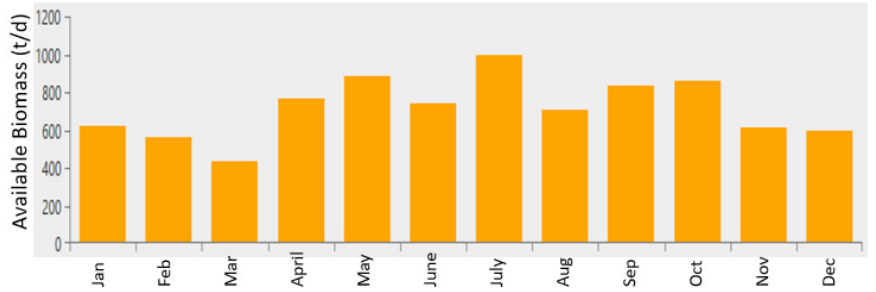
Figure 2. Daily available biomass over a year (tons/day).